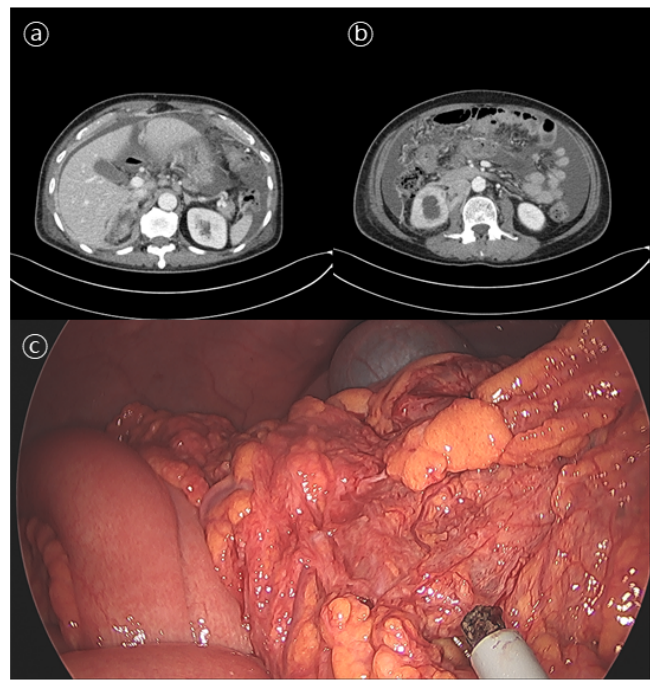
Figure 1. Abdominal computed tomography ( a , b ) and diagnostic laparoscopic biopsy ( c ) results. ( a ) Abdominal computed tomography showing metastatic lymph nodes in left gastric, retrocaval, aortocaval, and left paraaortic areas. ( b ) Abdominal computed tomography showing massive ascites and peritoneal seeding. ( c ) Diagnostic laparoscopic biopsy showing multiple nodular lesions in the omentum.